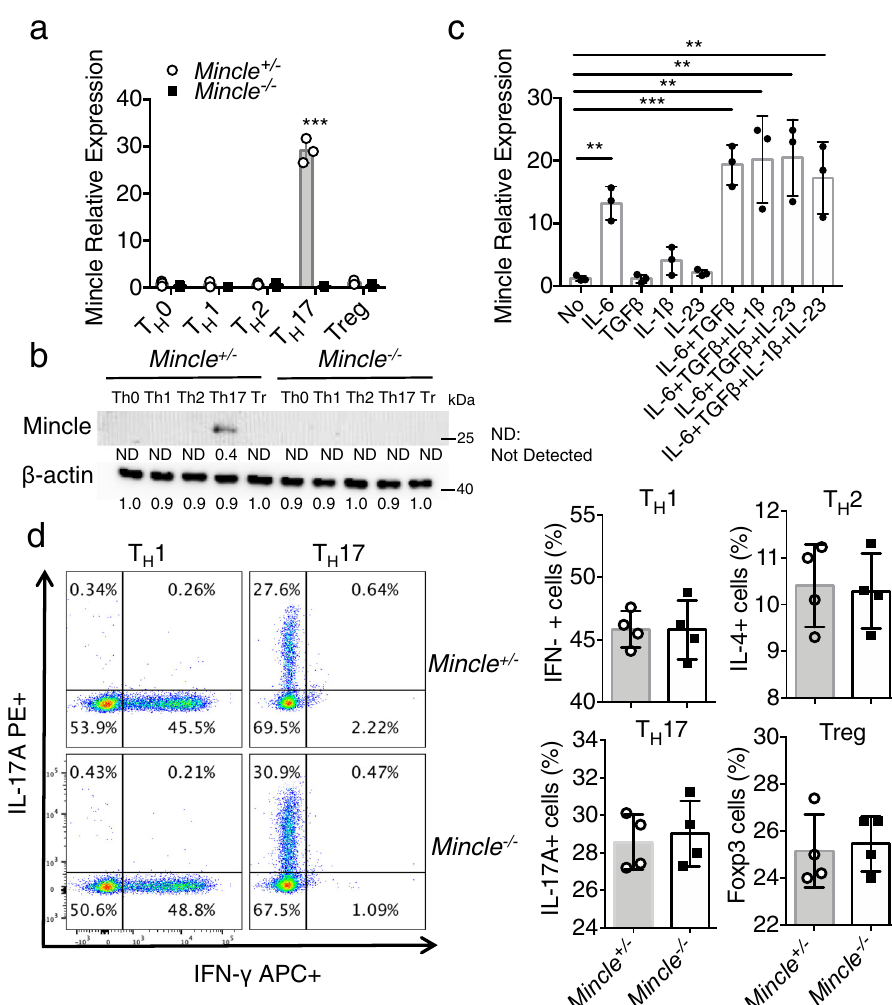
Fig. 1 Mincle is speci fi cally expressed in T H 17 cells. a Real-time PCR analysis for mRNA levels of Mincle in T H 0, T H 1, T H 2, T H 17, and Treg cells after 3 days polarization. The expression levels were normalized to the expression of β -actin, n = 3 biological replicates. b Western analysis of Mincle protein in polarized T H 1, T H 2, T H 17, and Treg cells from WT and Mincle -de fi cient mice, β -actin as a loading control, data are representative of three independent experiments, density values measured using Image J for the representative blot shown, ND not detected. c Real-time PCR analysis for Mincle mRNA levels in CD4 + cells stimulated with anti-CD3/CD28 in the presence of indicated cytokines for 72 h, n = 3 biological replicates. d Flow cytometry analysis of wild-type and Mincle -de fi cient T H 1, T H 1, T H 17, and T reg cells with the indicated antibodies, n = 4 biological replicates. *** P < 0.001 (Two sided student ’ s t test for a and d , Two-way ANOVA for c ) Data are represented as mean ± SD. Exact P values for asterisks (from left to right): a 0.00004, c 0.0015, 0.0007, 0.0089, 0.0056,